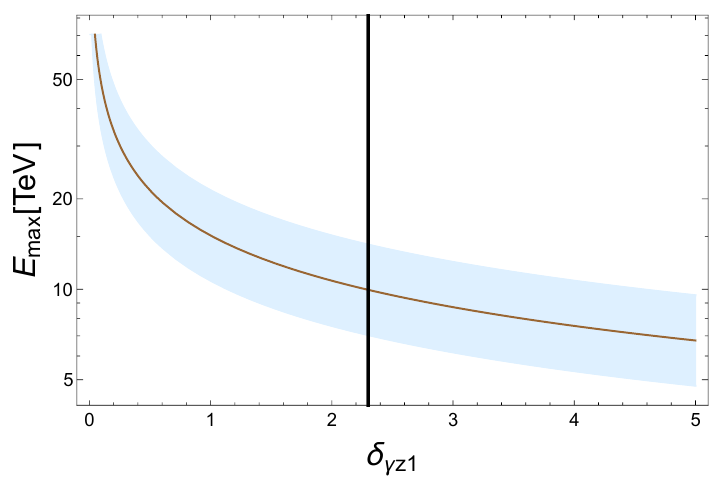
Figure 8 . The unitarity bound as a function of δ γZ 1 . The model-independent bound is obtained from eq. (4.6). The band around the model-independent bound results from varying the unitarity bound to 1 ≤ ˆ M ≤ 2 . The solid black line represents the 95% C.L. limits on δ γZ 1 from ATLAS [27]. 2 The HL-LHC projections are